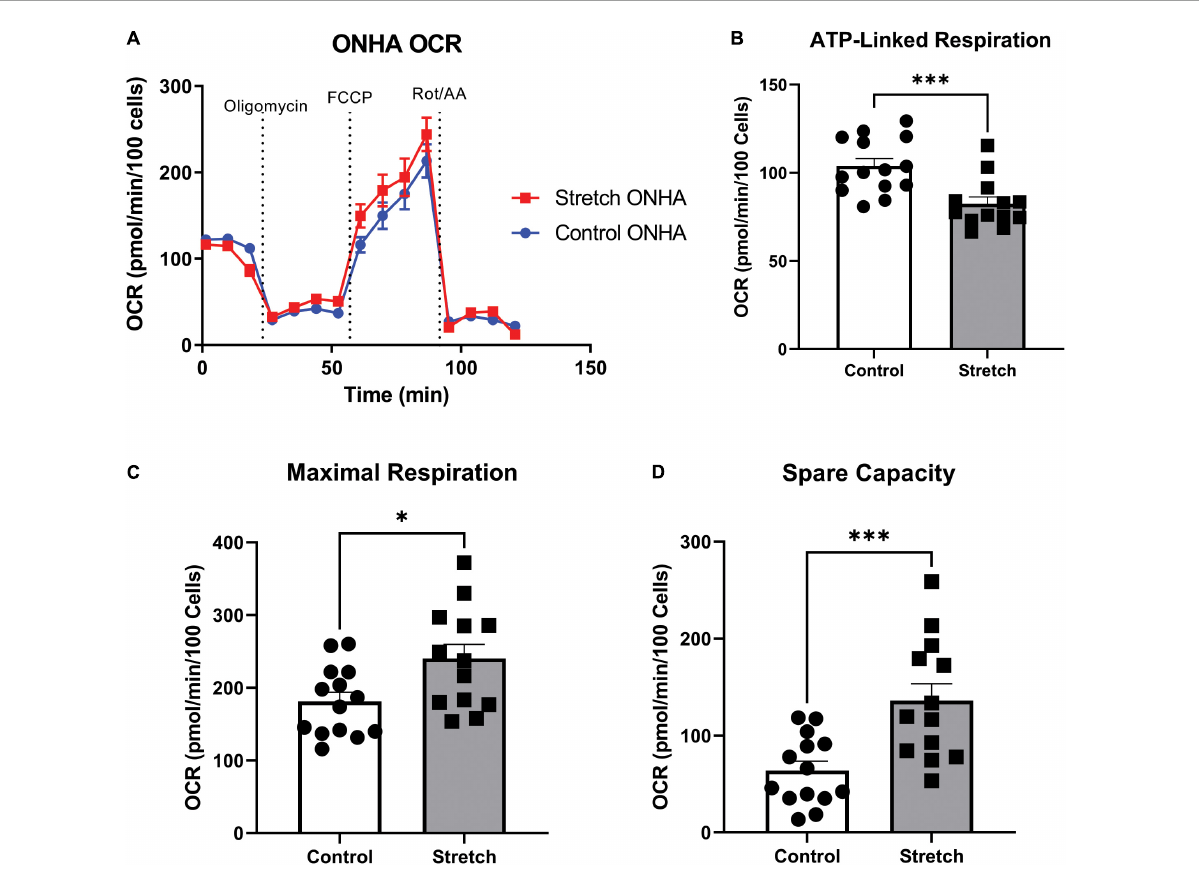
FIGURE3 Optic Nerve Head Astrocytes (ONHAs) stretched as in glaucoma have altered mitochondrial respiration compared to control ONHAs . (A) Stretched ONH astrocytes have no difference in basal oxygen consumption rate (OCR) when compared to Control. Graph shows one representative example of OCR taken from the three biological replicates analyzed over 20–30 wells. (B) Stretched ONH astrocytes have a significantly lower ATP-linked mitochondrial OCR than control ONH astrocytes (*** p = 0.0009, n = 27). (C,D) Stretched ONH astrocytes have a higher maximal respiration and spare capacity than control ONH astrocytes (* p = 0.0157, n = 27; *** p = 0.0010, n =